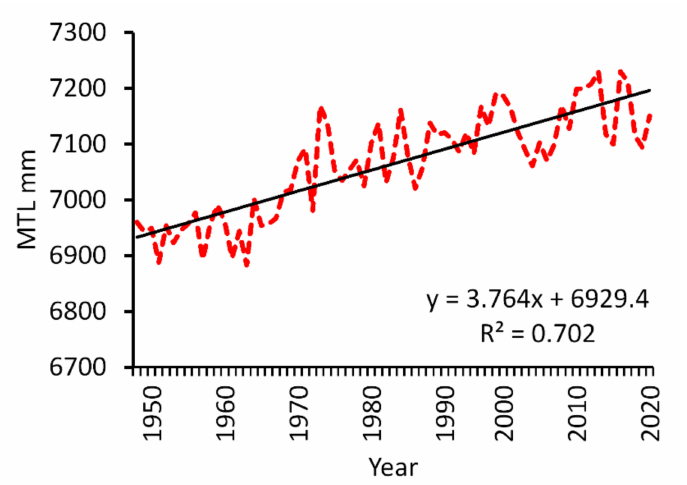
Figure 6. Mean sea-level rise at Diamond Harbor. MTL stands for mean tide level (source: Permanent Service for Mean Sea Level (https://www.psmsl.org/data/obtaining/stations/417.php accessed on 21 January 2021) and Kolkata Port